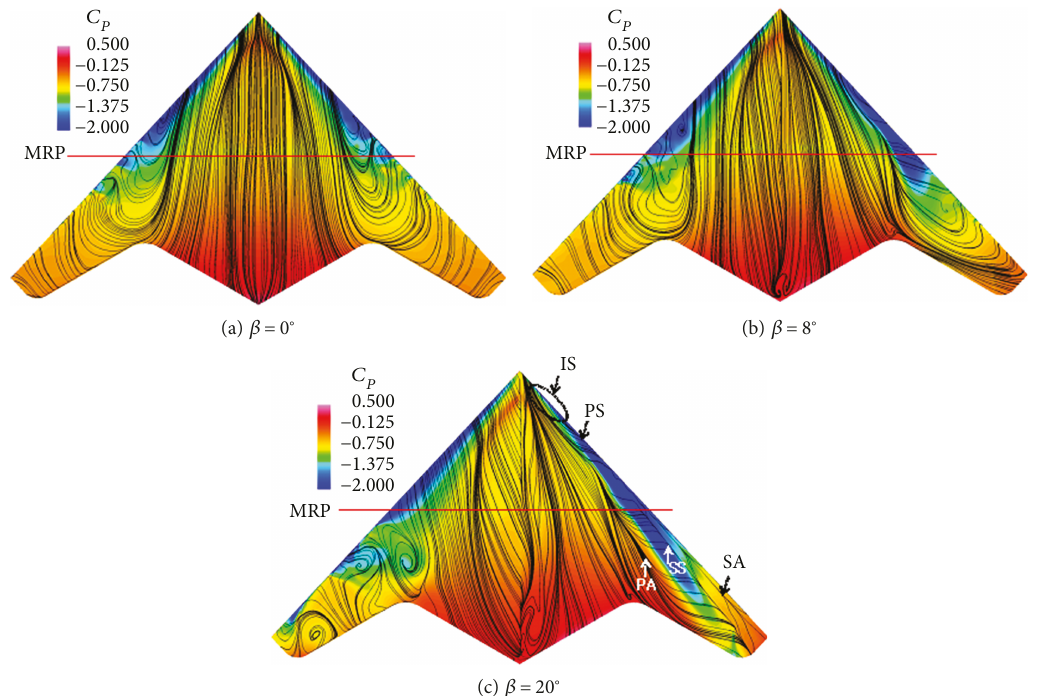
Figure 12: Skin friction lines and pressure coe ffi cient contours at angle of attack 16 ° .